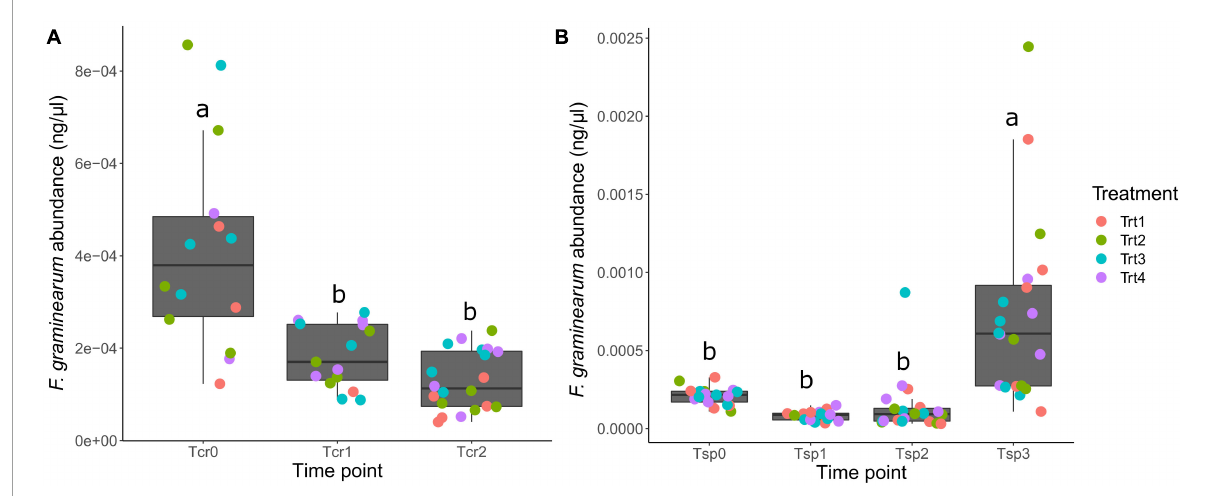
FIGURE3 Abundance of F. graminearum over time in (A) crop residue and (B) wheat spikes. See the text for a complete description of the sampling time points (T cr 0, T cr 1, T cr 2; T sp 0, T sp 1, T sp 2, T sp 3). Individual data points are colored by treatment, where Trt1 (non-inoculated control), Trt2 (T6085 applied to spikes at anthesis), Trt3 (T6085 applied to crop residue) and Trt4 (T6085 applied to both spikes and to crop residue). Box plots indicate the 1st quartile, median and 3rd quartile. Different letters within each panel indicate significant differences between the time points (log-transformed F. graminearum abundances modeled on treatment, time point, the interaction between treatment and time point, and the blocking factor in the experimental design; Tukey HSD contrasts among time points, p ≤